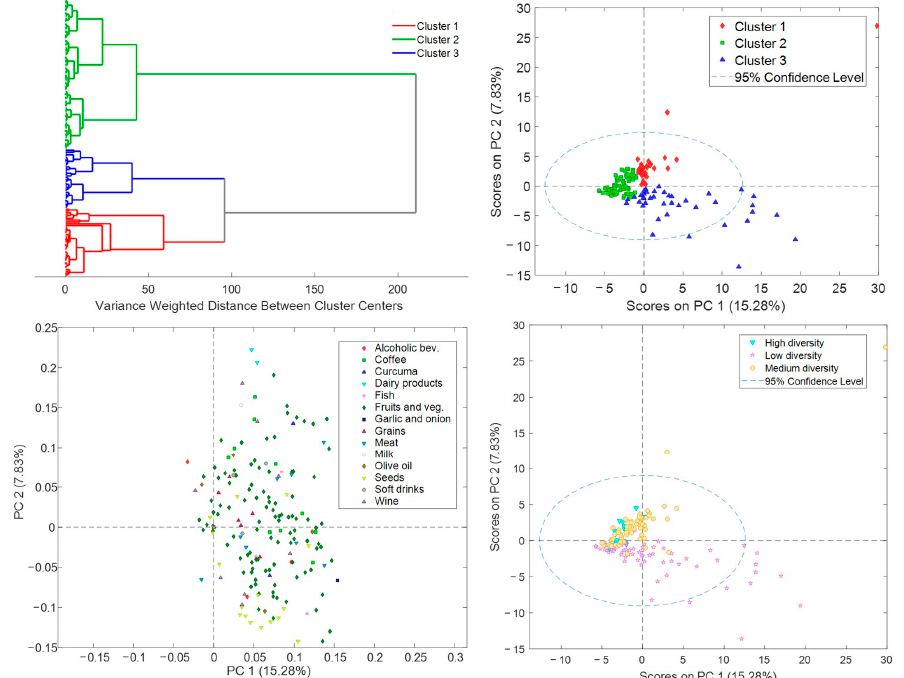
Figure 4. BFIs patterns in mothers’ urine samples. Top : Hierarchical clustering analysis revealing three sub-groups within the study samples ( left ) and PCA scores plot ( right ). Bottom : loadings plot ( left ) and PCA scores plot with Simpson’s Index of Diversity classes ( right ).